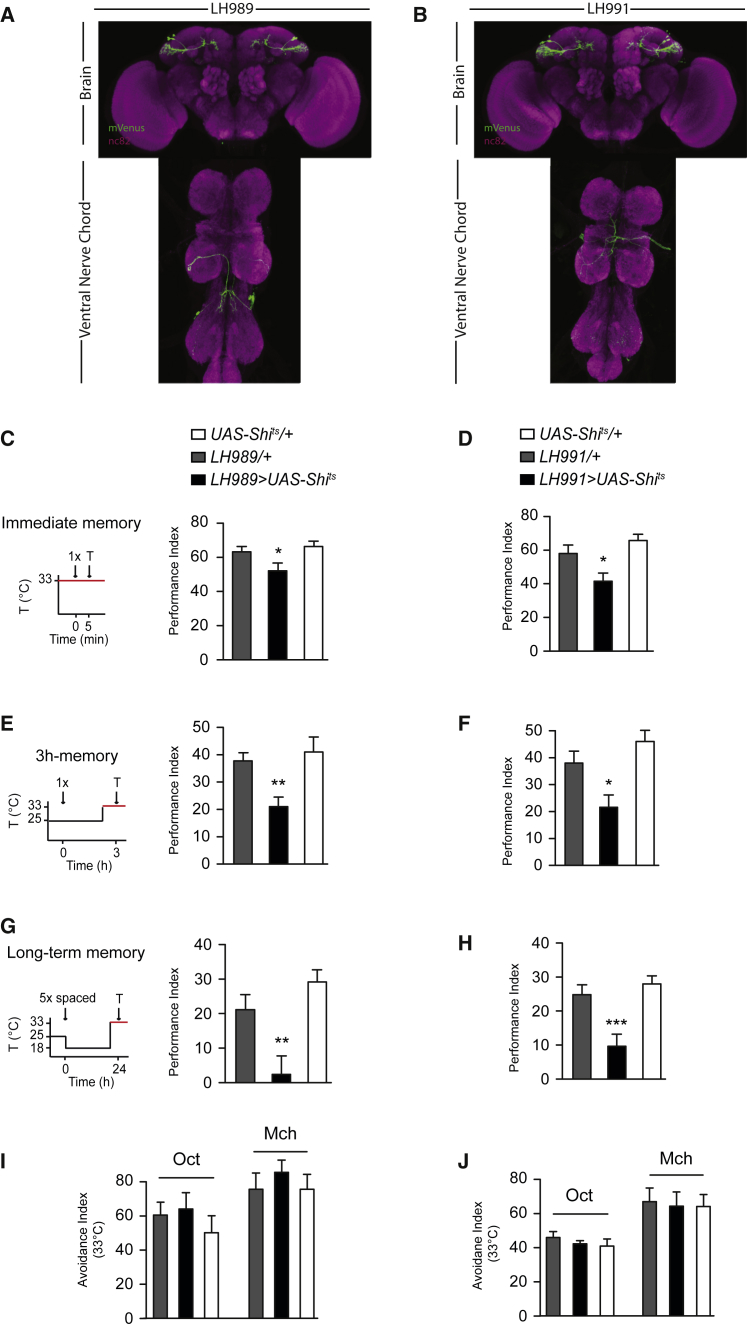
Specific Control with the Split-GAL4 System Confirms PD2a1 and PD2b1’s Role in Memory Retrieval, but Not Innate Behavior(A and B) Confocal z-projections of split-GAL4 lines targeting PD2a1 and PD2b1 neurons, LH989 (A) and LH991 (B). mVenus membrane stain, green; neuropil, magenta. Flies expressing Shits by the split-GAL4 lines LH989 or LH991 were trained and tested according to the illustrated protocols along with genotypic controls (restrictive temperature in red).(C and D) Silencing PD2a1 and PD2b1 neurons using LH989 (C; n = 14–15, F(2,42) = 4.13, p = 0.02) or LH991 (D; n = 18, F(2,53) = 7.27, p = 0.0017) impaired immediate memory after single-cycle training.(E and F) Silencing PD2a1 and PD2b1 neurons during the retrieval phase 3 hr after single-cycle training using LH989 (E; n = 14, F(2,42) = 6.73, p = 0.0031) or LH991 (F; n = 11–13, F(2,35) = 8.23, p = 0.0013) caused a memory defect.(G and H) Silencing PD2a1 and PD2b1 neurons during the retrieval phase 24 hr after spaced training using LH989 (G; n = 7–9, F(2,23) = 9.79, p = 0.0010) or LH991 (H; n = 19–23, F(2,72) = 10.83, p < 0.0001) abolished performance.(I and J) Silencing PD2a1 and PD2b1 neurons using LH989 (I; Oct, n = 8–12, F(2,29) = 0.63, p = 0.54; Mch, n = 10, F(2,29) = 0.44, p = 0.65) or LH991 (J; Oct, n = 7–8, F(2,22) = 0.25, p = 0.78; Mch, n = 7, F(2,20) = 0.068, p = 0.93) had no effect on naive avoidance of Oct or Mch.∗p < 0.05, ∗∗p < 0.01, ∗∗∗p < 0.001. Data are presented as mean ± SEM. See also Figures S4 and S5.